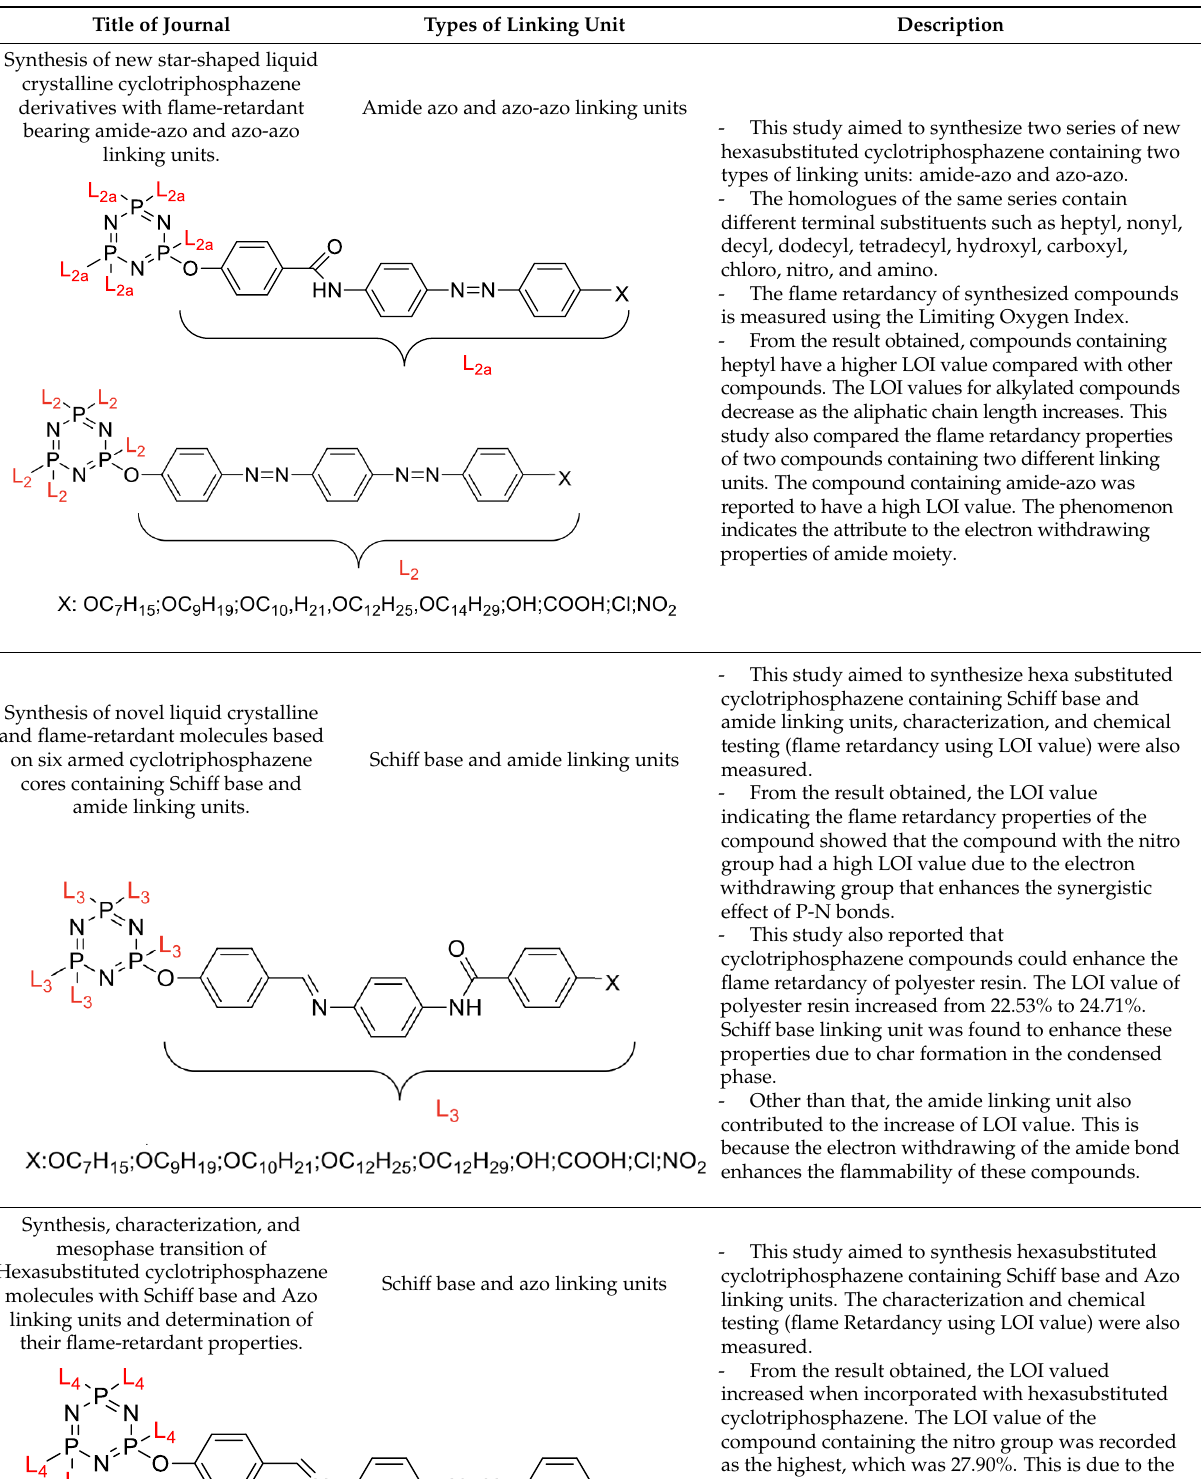
Table 2. Synthesis of the hexasubstituted cyclotriphosphazene compound with several types of linking units.